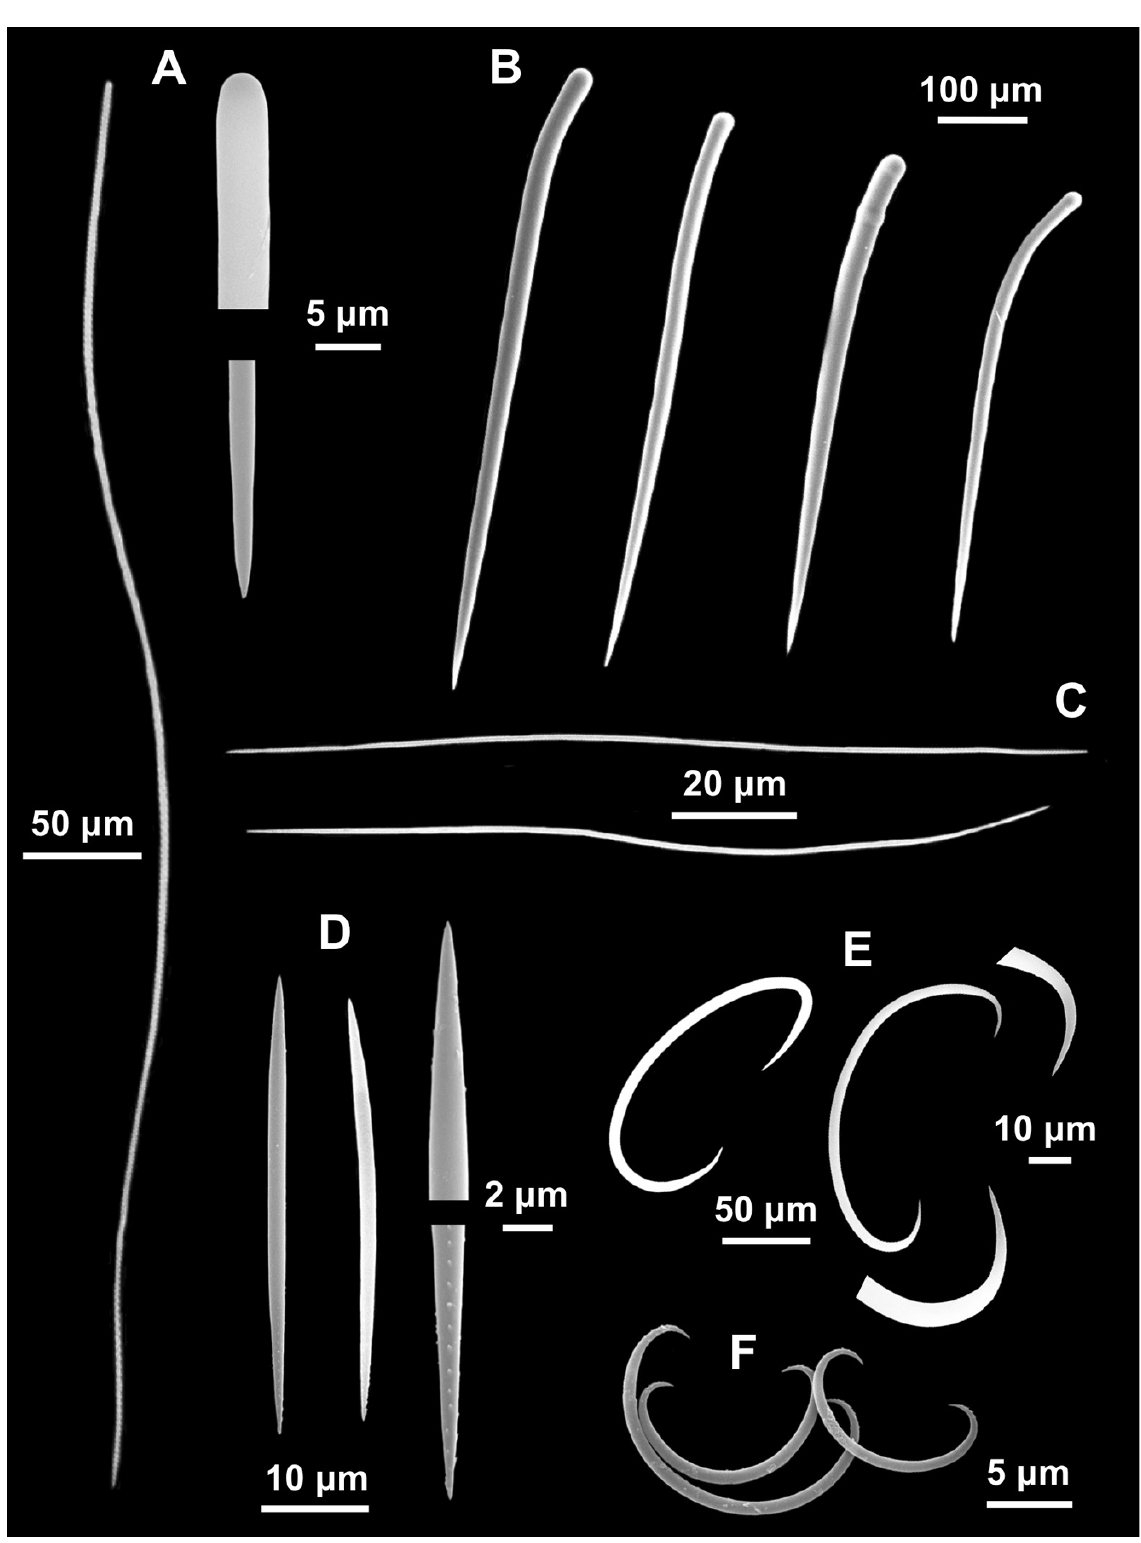
Fig. 10. Spicules of Biemna erecta Bertolino, Costa & Pansini sp. nov., holotype (CILE 74; MSGN 61496). A . Styles. B . Tylostyles / subtylostyles. C . Raphids I. D . Raphids II. E . Sigma I. F . Sigma